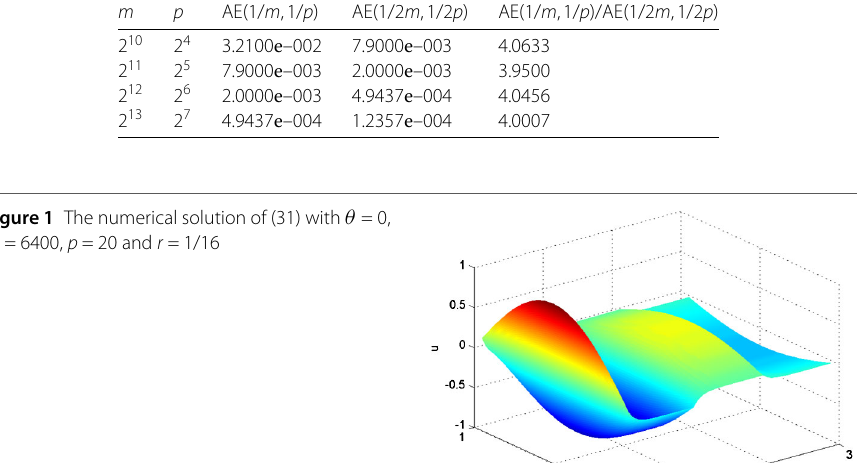
Table 4 Errors of (32) with θ = 1/2